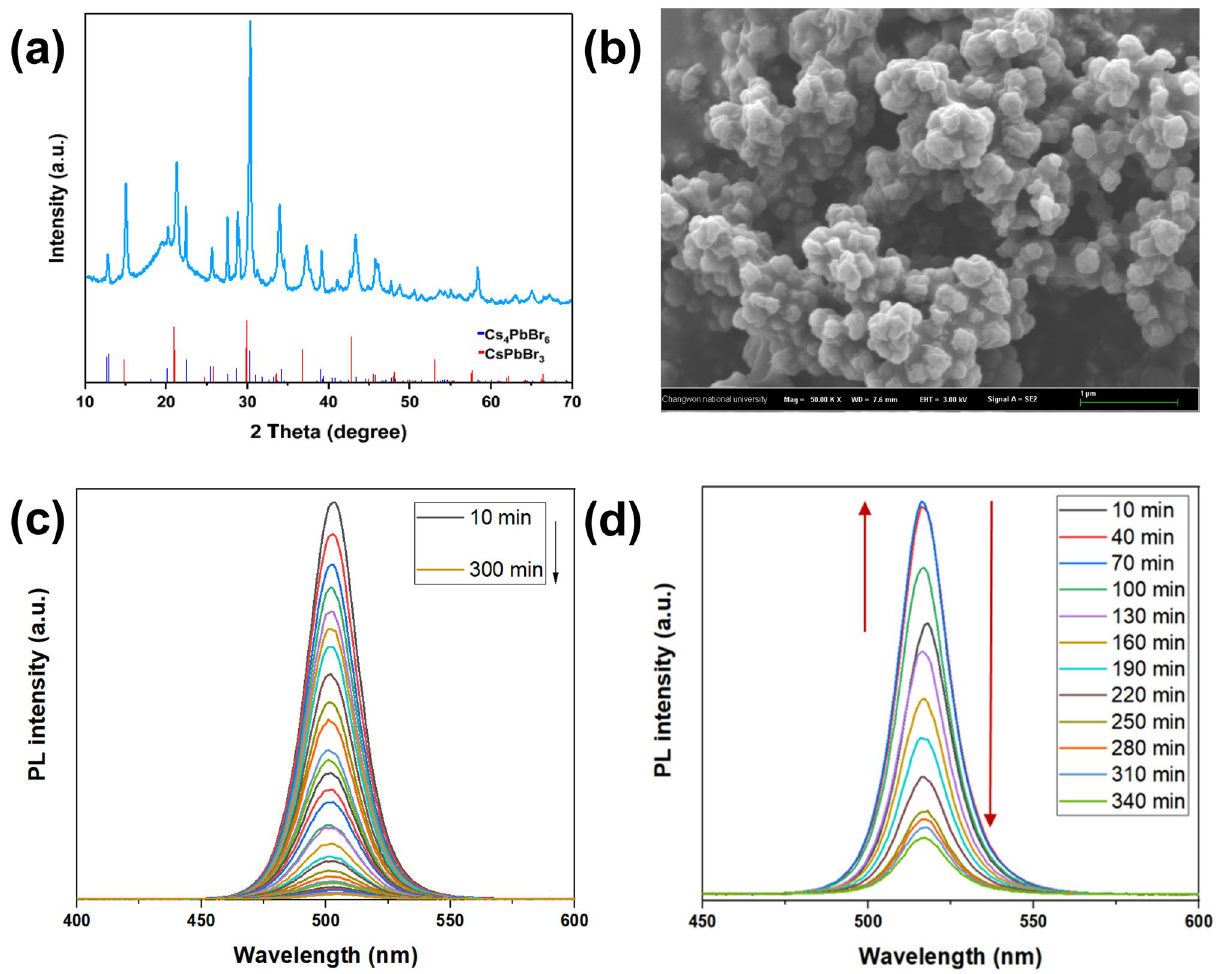
Figure 4. Characterization of perovskite-loaded MIP nanogels by XRD ( a ) and LV-SEM image ( b ). PL spectra of perovskite-loaded MIP nanogel in water: nanogel prepared from GA-HEMA: CA-HEMA: OA-HEMA (1 eq: 1 eq: 1 eq) ( c ) and nanogel prepared from GA-HEMA: CA-HEMA: OA-HEMA: PEG-HEMA (1 eq: 1 eq: 1 eq: 3 eq) ( d